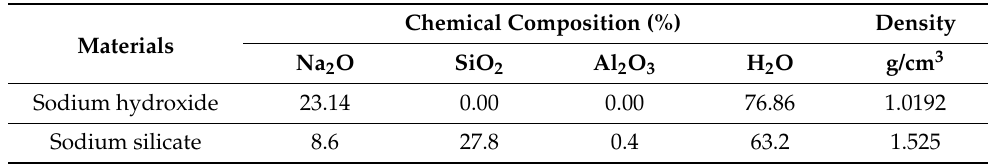
Table 2. Chemical composition (%) and density of sodium hydroxide (SH) and sodium silicate (SS) in (g/cm 3